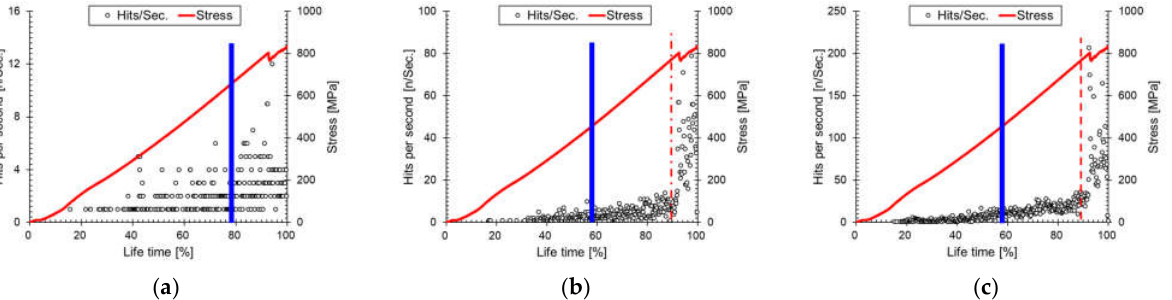
Figure 10. AE hits per second according to fracture mode: ( a ) matrix cracking, ( b ) interfacial failure, and ( c ) fiber failure.